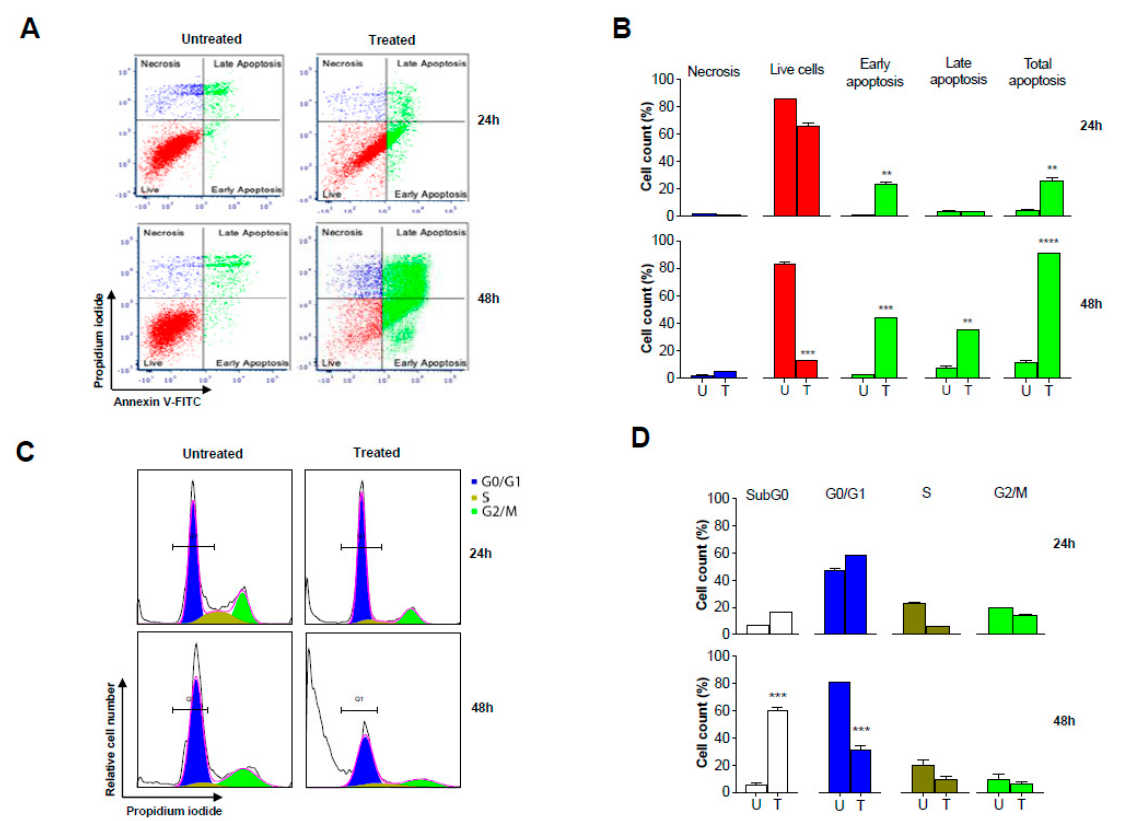
Figure 7. GS induced apoptosis in HCT 116 cells but no cell cycle arrest. HCT 116 cells were left untreated or treated with GS (50 µM) for 24 and 48 h. ( A ) The cells were then stained with Annexin V FITC and propidium iodide (PI) and analyzed by flow cytometry for apoptosis. ( B ) Percent distribution of necrosis, live cells, and apoptosis at 24 h and 48 h. ( C ) The cells were stained with PI and DNA content analyzed by flow cytometry to determine the cell cycle distribution. ( D ) Percent distribution of the cells on phases of cell cycle. ** p < 0.005, *** p < 0.001, **** p < 0.0002.